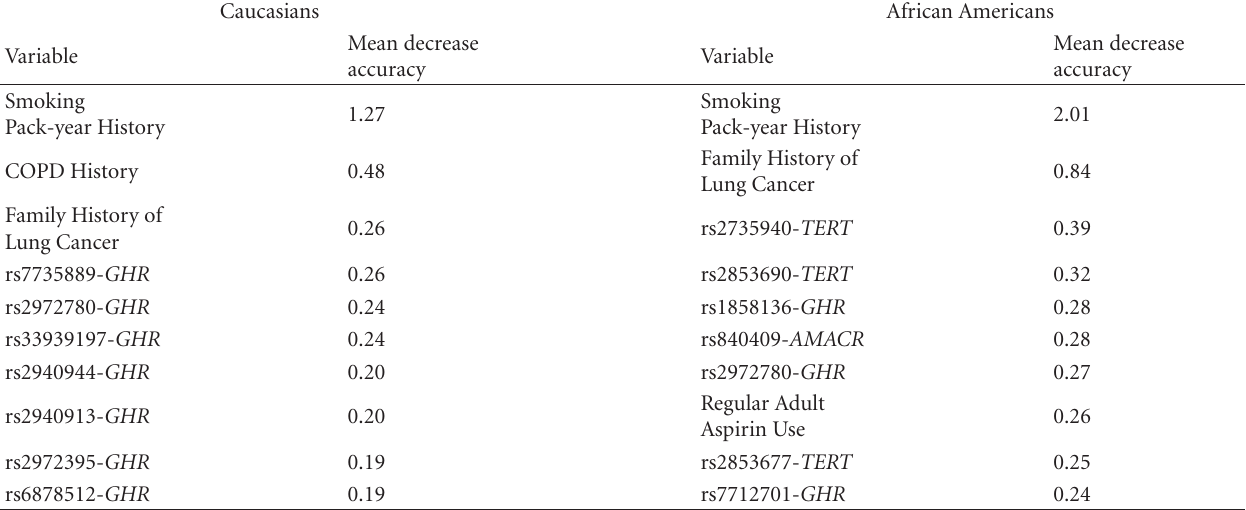
Table 3: Top ten variables classifying NSCLC case-control status by race on random forest analysis